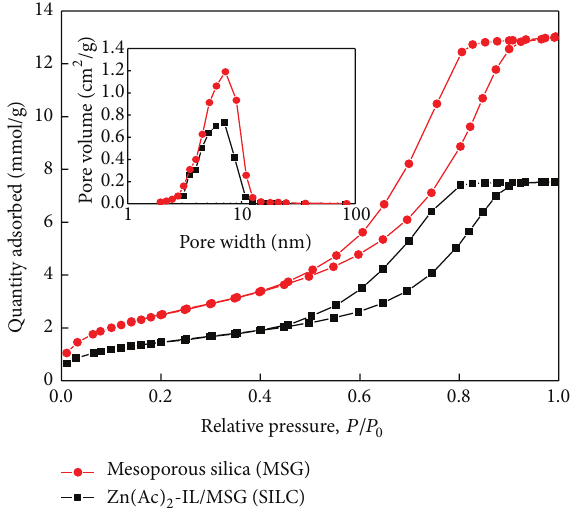
Figure 4: N 2 adsorption-desorption isotherms and pore diameter distributions of Zn(Ac) 2 -IL/MSG and